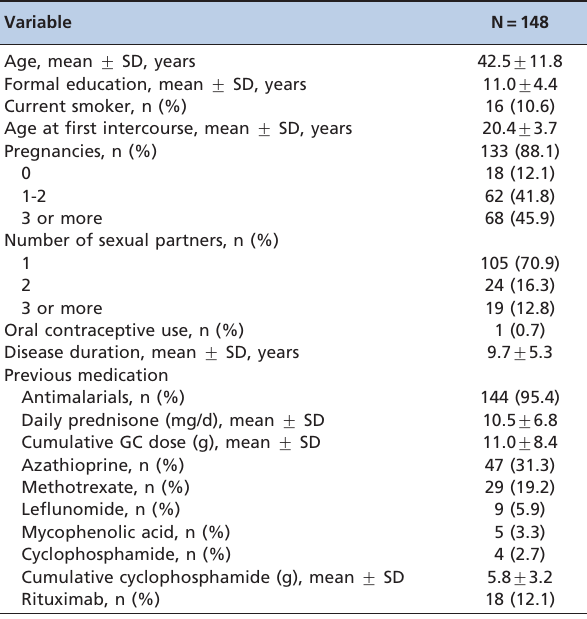
Table 1 - Sociodemographic, clinical, and treatment characteristics of patients with systemic lupus